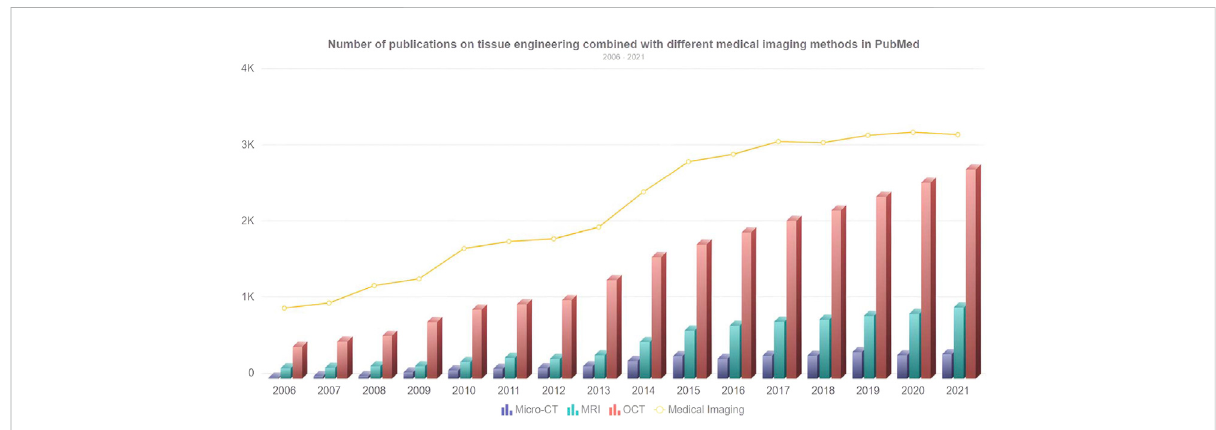
FIGURE 4 Number of publications on tissue engineering combined with different medical imaging methods in PubMed. The line chart represents the overall trend of the number of searches for medical imaging keywords, and the bar chart represents the number of searches for micro-CT, MRI, and OCT from 2006 to